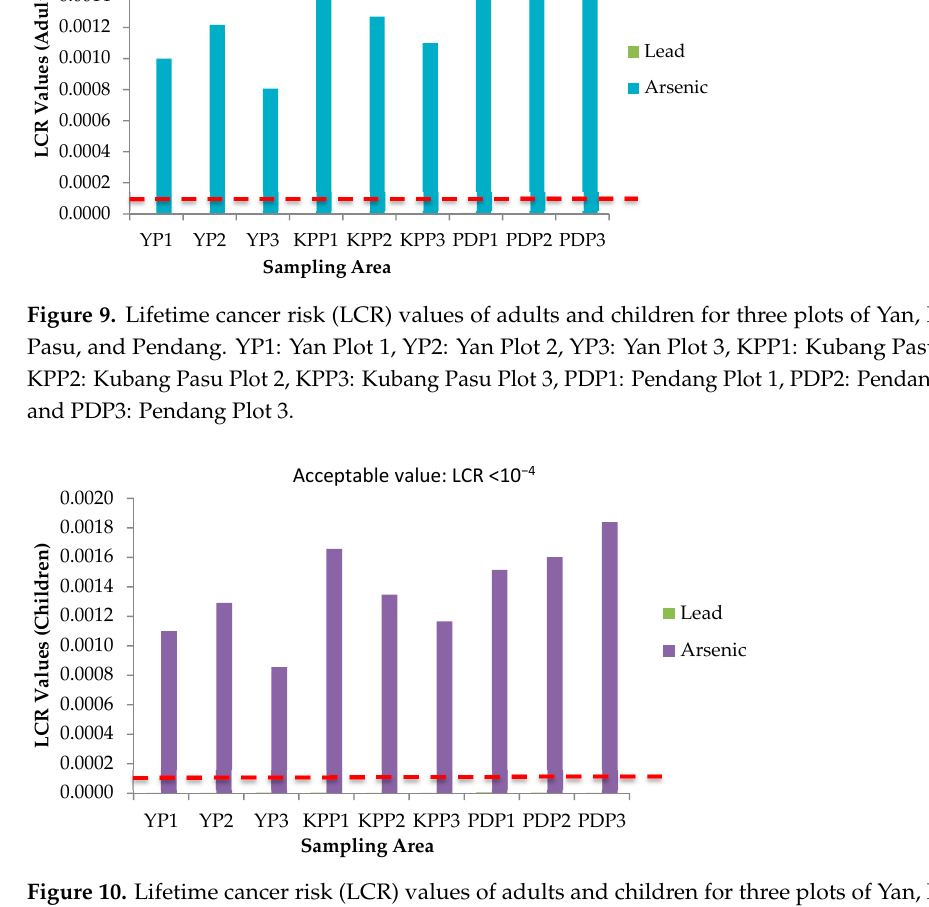
Figure 10. Lifetime cancer risk (LCR) values of adults and children for three plots of Yan, Kubang Pasu, and Pendang. YP1: Yan Plot 1, YP2: Yan Plot 2, YP3: Yan Plot 3, KPP1: Kubang Pasu Plot 1, KPP2: Kubang Pasu Plot 2, KPP3: Kubang Pasu Plot 3, PDP1: Pendang Plot 1, PDP2: Pendang Plot 2, and PDP3: Pendang Plot 3.